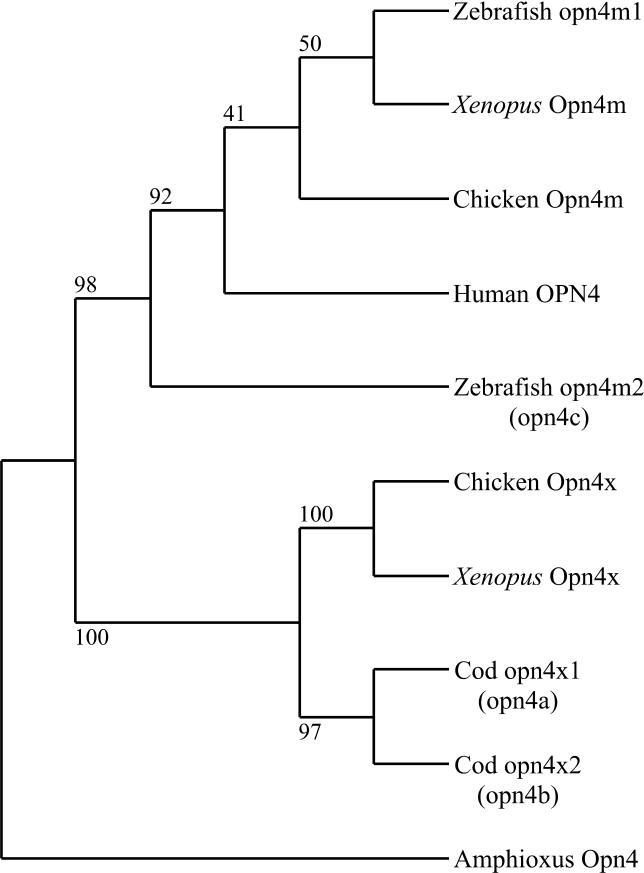
A Revised Phylogeny and Nomenclature of the Vertebrate Melanopsin FamilyA maximum parsimony phylogenetic tree (derived from amino acid sequences 310 sites, 151 informative, rooted with Amphioxus Opn4) showing the relationship between the novel nonmammalian Opn4m melanopsins and previously published Opn4x melanopsin sequences. Branch confidence levels (% based on 500 bootstrap replicates) reveal an evolutionarily ancient split into the Opn4m and Opn4x branches. The teleost melanopsin nomenclature previously suggested by Drivenes et al. [
17] is shown in parenthesis; see text for more details.